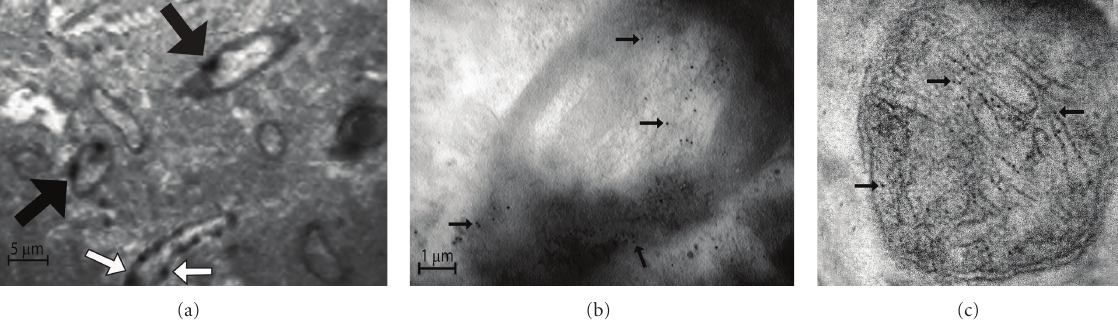
Figure 1: A β stain by immunoelectron microscopy. 36 hours after the intracerebral injection of A β tissues from the injected area were obtained and subjected to immunohistochemistry by using a primary polyclonal antibody against A β . Deposits of A β forming deposits in the extracellular space were revealed by conventional light microscopy (data not shown). A β immunoreactivity was then revealed with a 6nm gold label and observed in a transmission electron microscope which allows us to identify (a) deposits of A β within myelin axons (black arrows) and in the vasculature (white arrows). (b) Deposits of A β (black arrows) penetrate the axon membranes causing demyelination and appear in the axons. Axons look like bulb onions. (c) A β appears within the mitochondria finally, where it forms deposits along the cristae (black arrows) and causes intense inflammation, destruction of membranes, and vacuolization (magnification at 27800x).